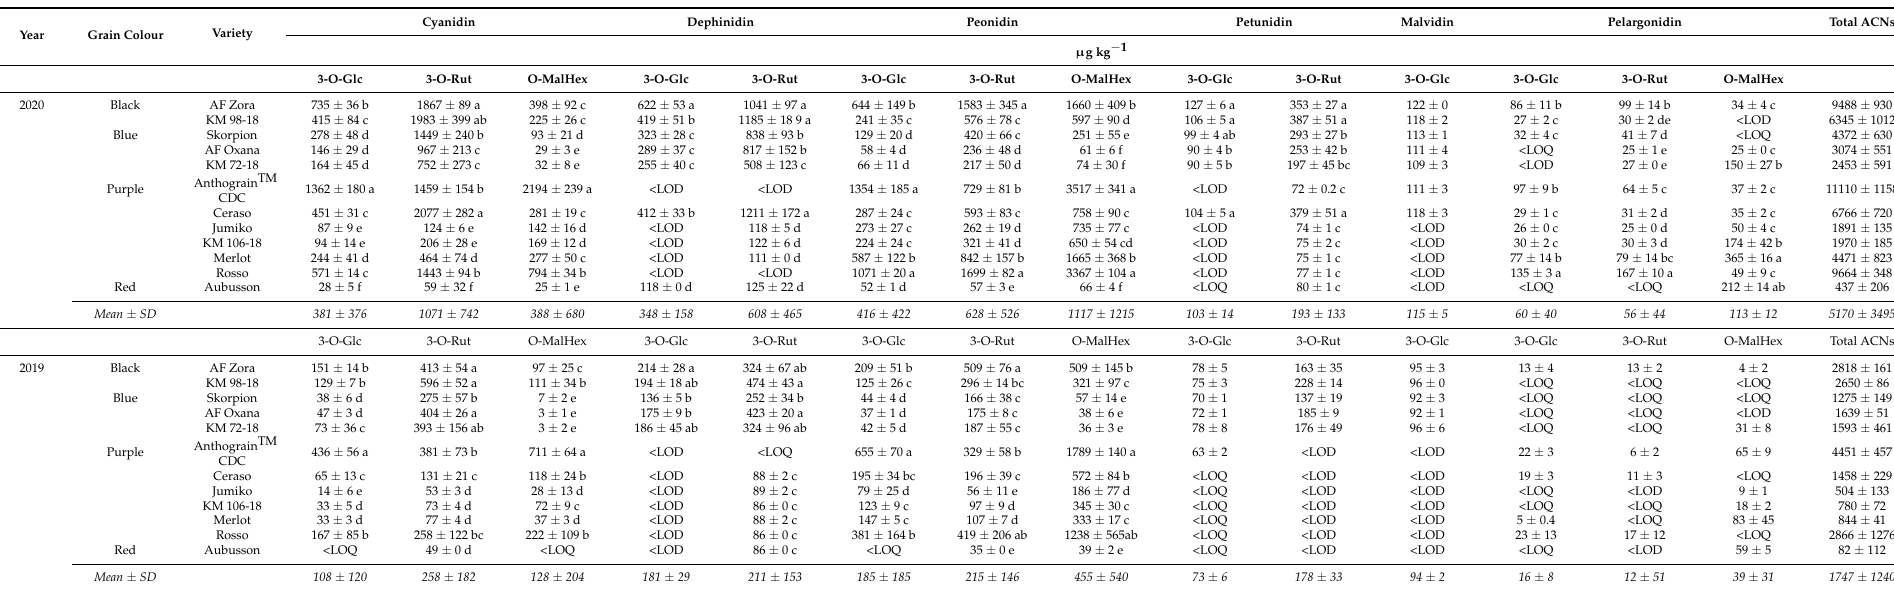
Table 2. Occurrence of anthocyanins in twelve varieties of coloured common wheat. Three biological replicates and three replicates were considered for each variety. Data are reported as means ± SD. Different letters indicate significant differences ( p < 0.005) among varieties within the same harvest